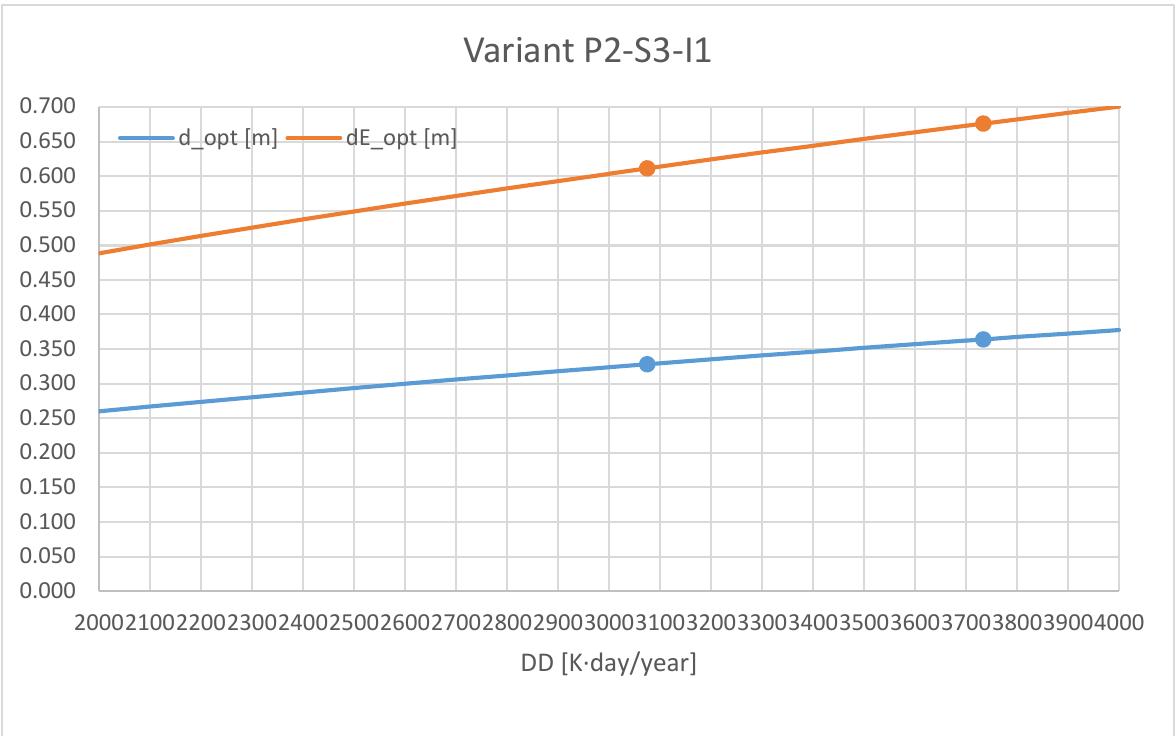
Figure 3. Optimal thermal insulation thickness d opt and d Eopt depending on the degree days DD for the P2-S3-I1 variant.